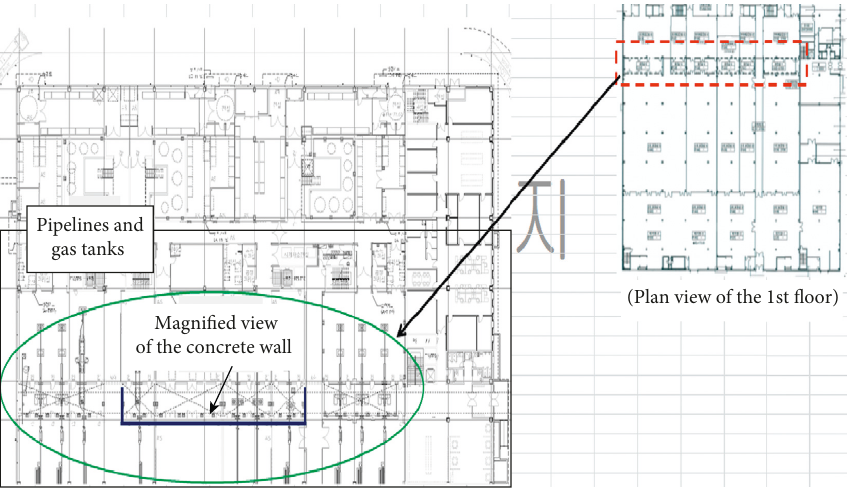
Figure 9: Plan view of the protection wall against flying debris due to